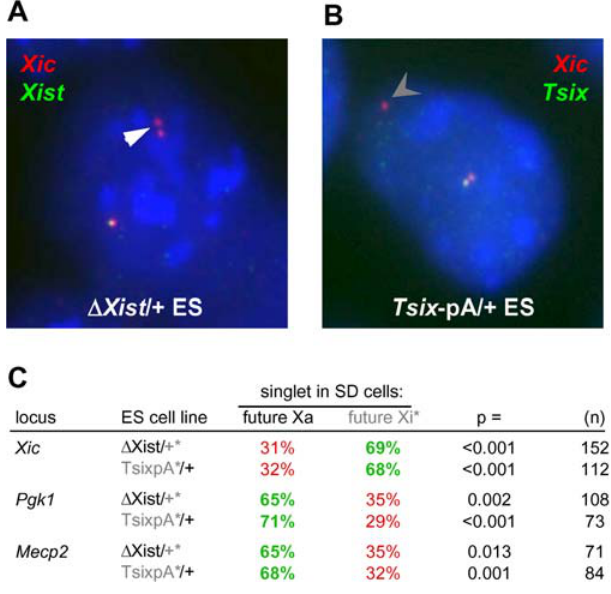
Figure 3. The Future Xa and Future Xi Exhibit Distinct Frequencies of Singlet FISH Signals (A) Allele-specific FISH for the Xic (red) in D Xist / þ ES cells. An Xist probe (green) identifies the wild-type allele. White arrowhead indicates the D Xist allele. (B) Allele-specific FISH for the Xic (red) in Tsix –pA/ þ ES cells. Tsix RNA (green) identifies the wild-type allele. Grey arrowhead indicates the Tsix – pA allele. (C) Table summarizing scoring of allele-specific FISH in D Xist / þ and Tsix – pA/ þ ES cells. For three X-chromosomal loci, SD cells were scored for identity of the allele displaying the singlet signal. The X chromosome indicated in black always becomes the Xa, and that in gray and marked with an asterisk always becomes the Xi. The allele indicated in green will be the expressed allele after X-inactivation and the allele indicated in red will be the silent allele. p -Values reflect the probability that the observed distributions are